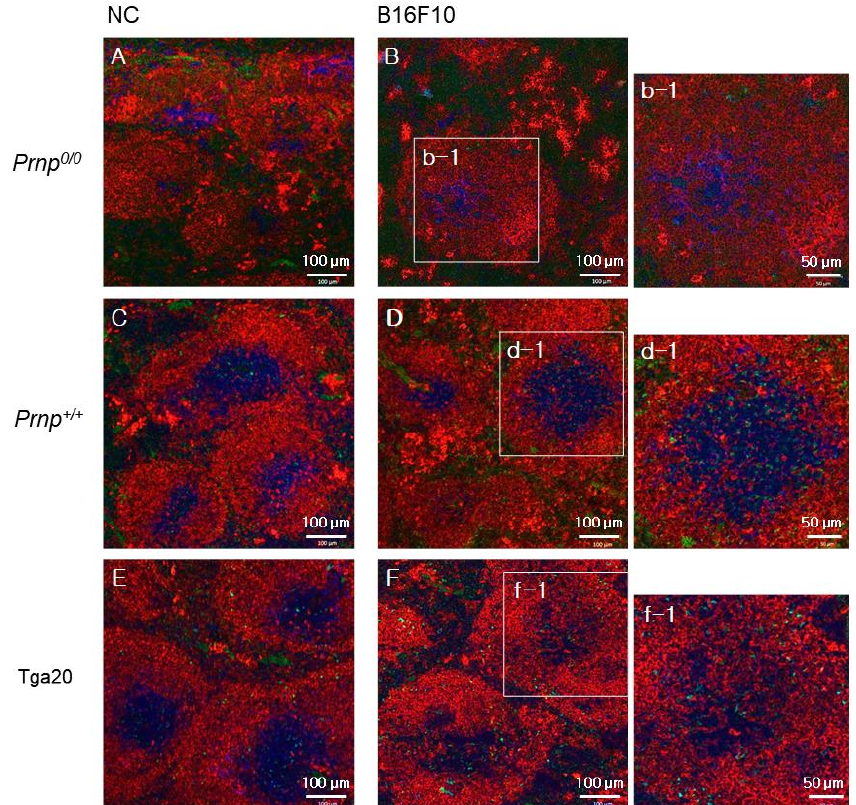
Figure 2. Low power confocal micrographs of Prnp 0/0 ( A , B ), Prnp +/+ ( C , D ), and Tga20 ( E , F ) mouse spleen sections showing white pulp. Images show CD3 (blue for T cells), IgM (red for B cells), and FoxP3 (green for Treg cells). ( A , C , E ) The spleens from normal mice (negative control, NC) and ( B , D , F ) from B16F10-treated mice (B16F10) at the terminal stage of lung cancer. High-power confocal images (b-1, d-1, and f-1) are from the area in the white boxes in B, D, and F. Data are representative of sections from three mice per group.